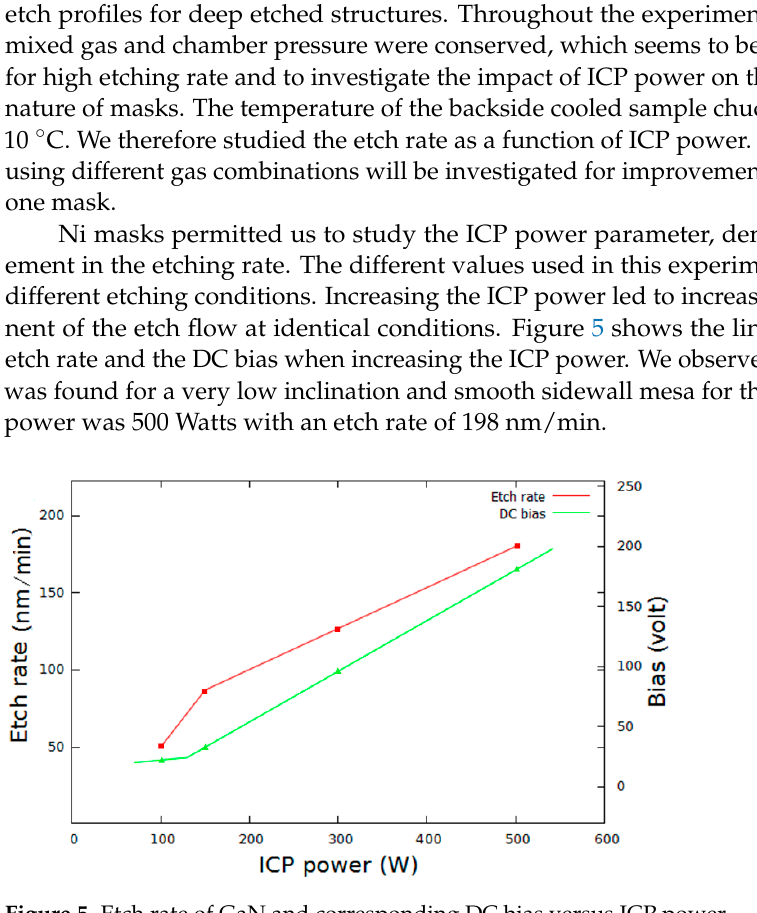
Figure 5. Etch rate of GaN and corresponding DC bias versus ICP power.